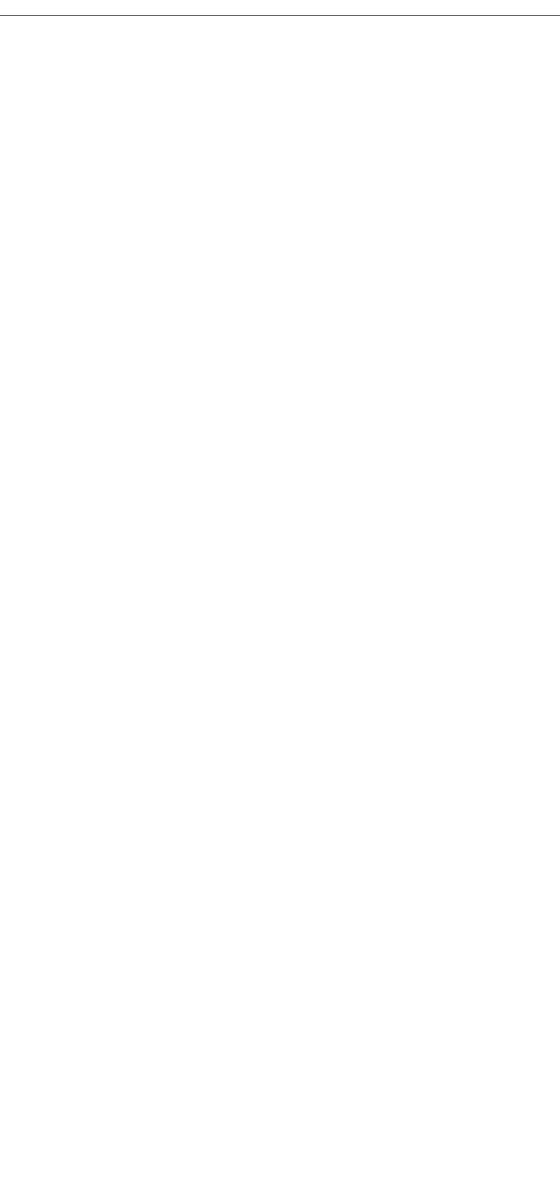
FIGURE A2 | Load-deformation relation of a steel frame with and without P- Δ effect (exact one and approximate one)